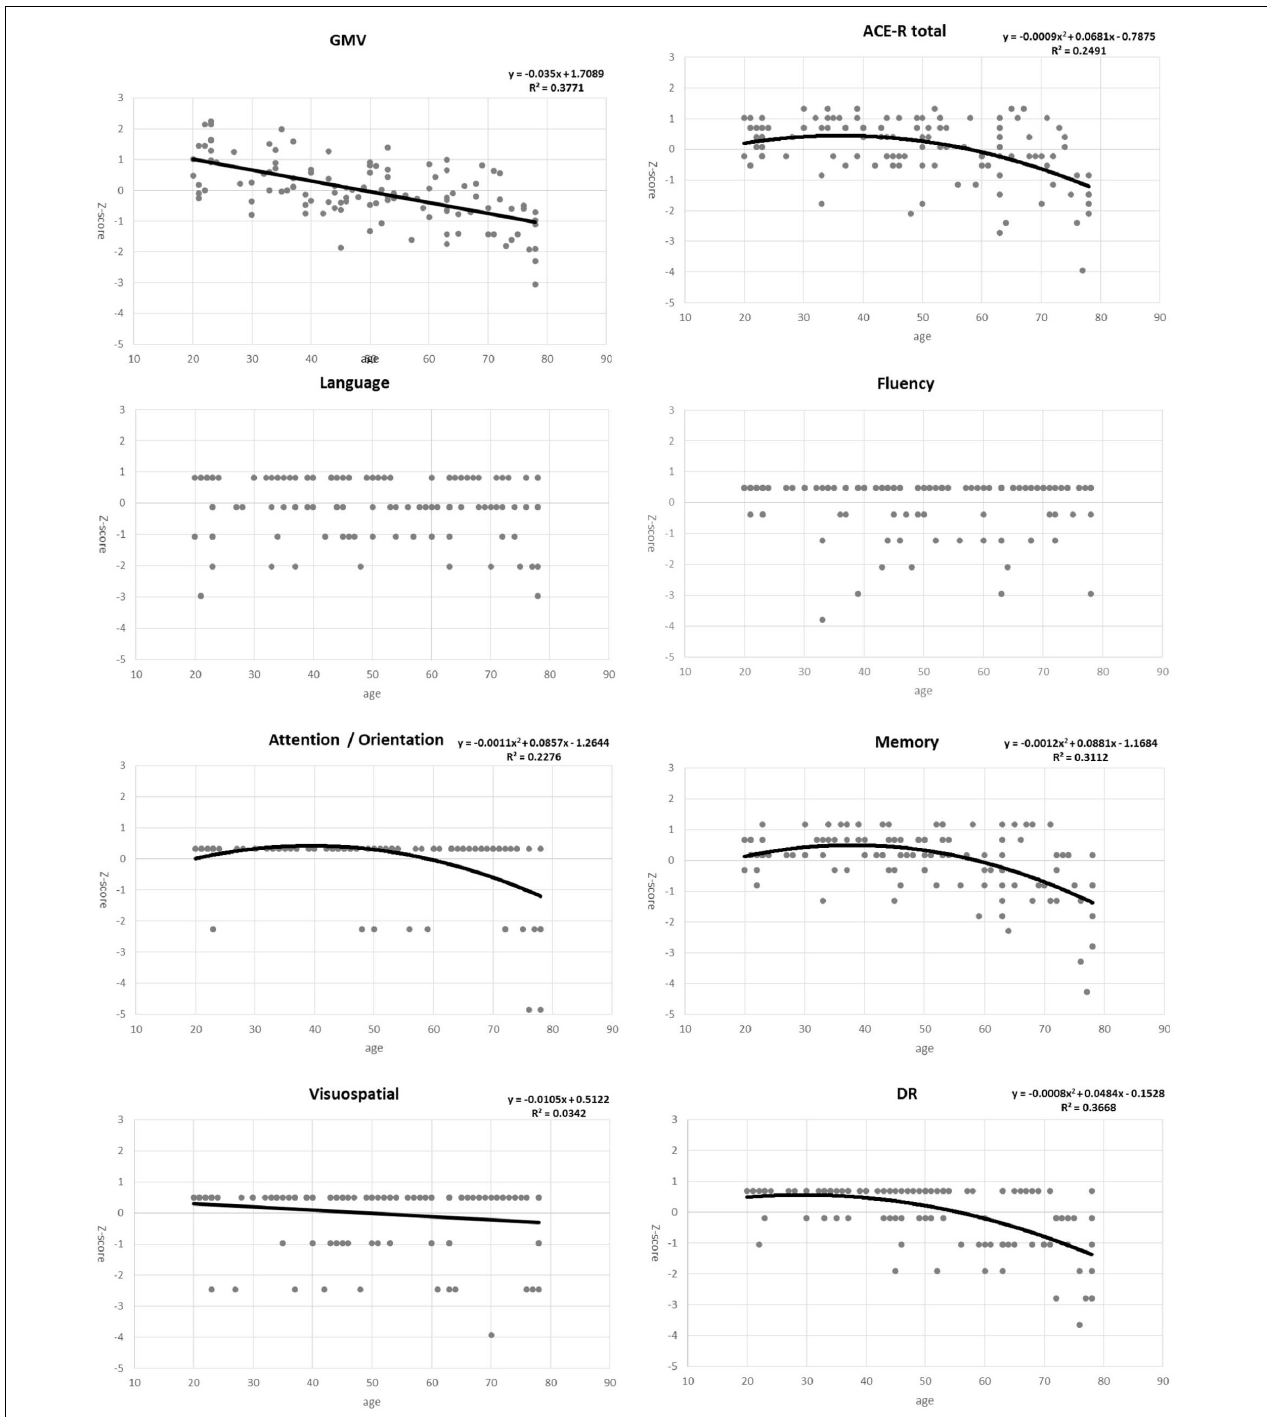
FIGURE 1 | Plots for gray matter volume (GMV), total ACE-R score, five domains of the ACE-R (attention/orientation, memory, fluency, visuospatial, and language), and the delayed recall (DR) score as functions of age. Points represent actual data, whereas solid line/curves represent regression functions.